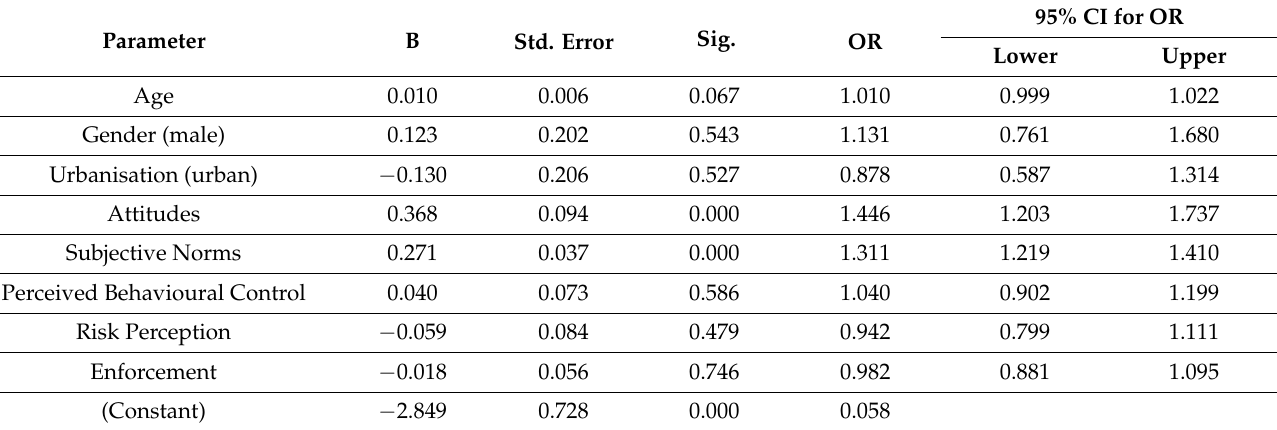
Table 5. Factors influencing speeding in built-up areas.